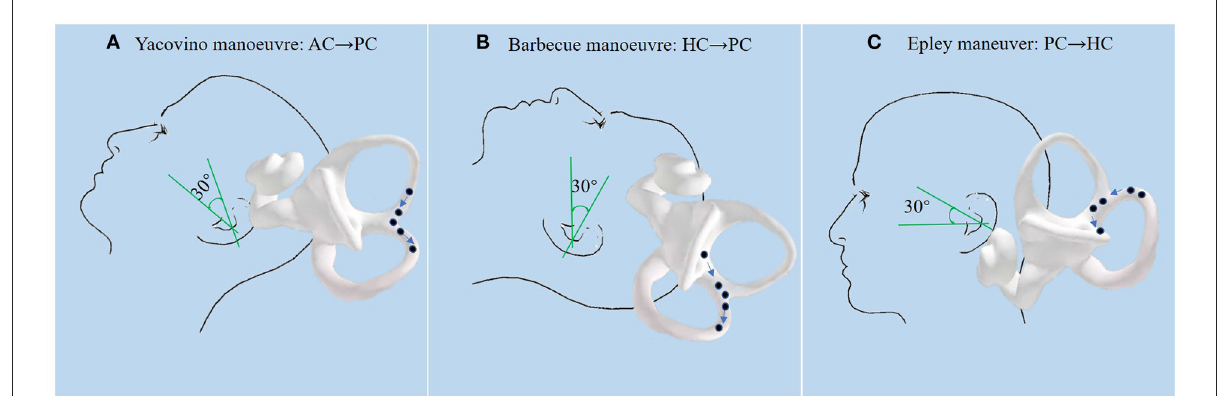
FIGURE3 (A) : During the Yacovino maneuver, when step 3 (flexing the patient’s neck to the chin-to-chest position) is completed and the next step is not performed in a timely manner, the otolith particles enter the PC through the common crus. (B) : During the Barbecue maneuver for HC-BPPV, if the patient is not brought from the supine position to the sitting position, the otolith particles that have been repositioned into the utricle enter the PC through the common crus under the action of gravity, which then enter the ampullary end of the PC when sitting up. (C) : During the last step of the Epley maneuver (sitting up), otolith particles enter the HC because of tilting of the head to the affected side after sitting